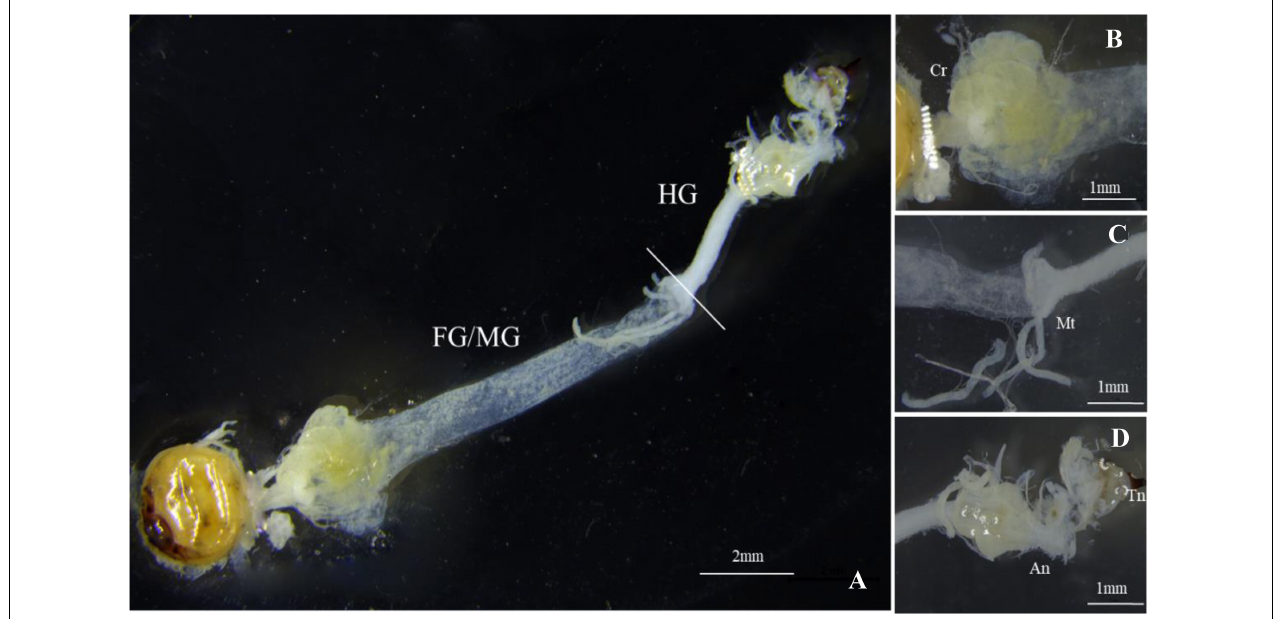
FIGURE 1 | Gut morphology of Sirex noctilio larva. (A) The digestive tract includes foregut (FG), midgut (MG), and hindgut (HG). Enlarged images of (B) Crop (Cr), (C) Malpighian tubules (Mt), and (D) Anus (An) and Tail needle (Tn). Photographs were taken using Leica M205FA, United States.